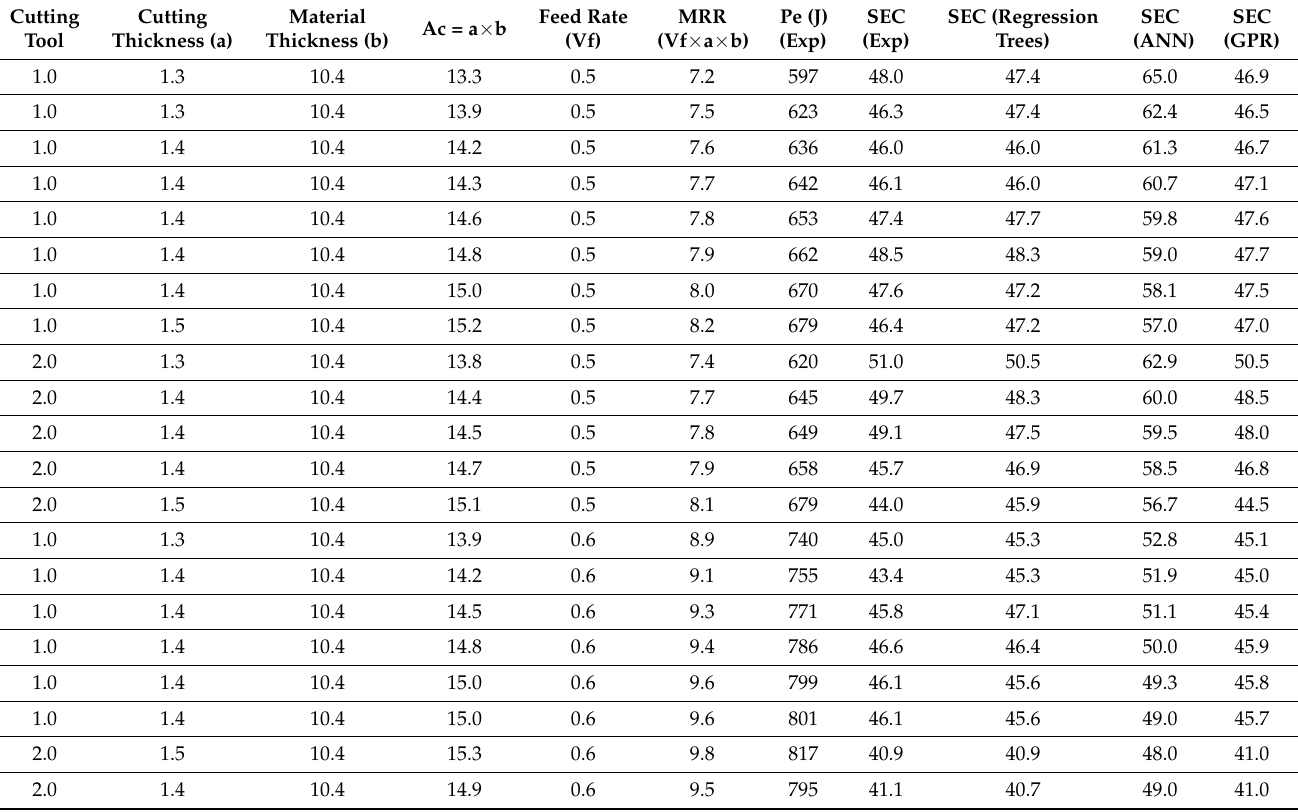
Table A1. Prediction of specific energy consumption (J/mm 3 ) using input process parameters of cutting tool, cutting thickness, material thickness, and feed rate). Cutting